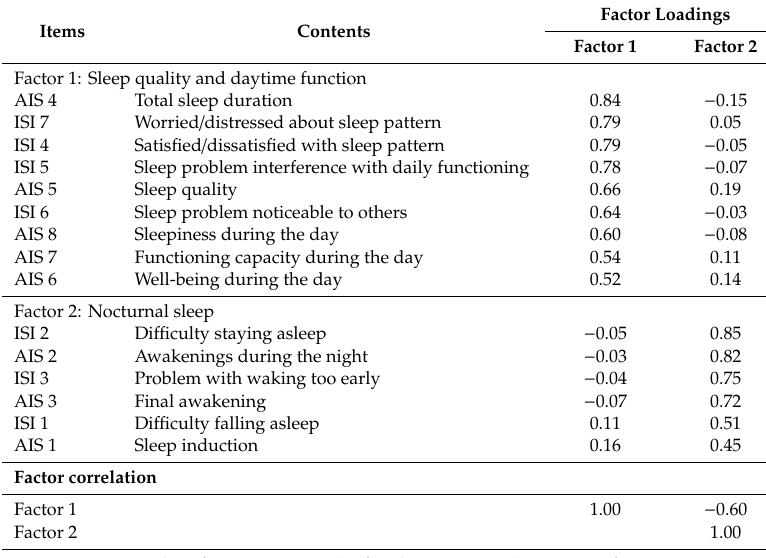
Table 2. Exploratory factor analysis for AIS and